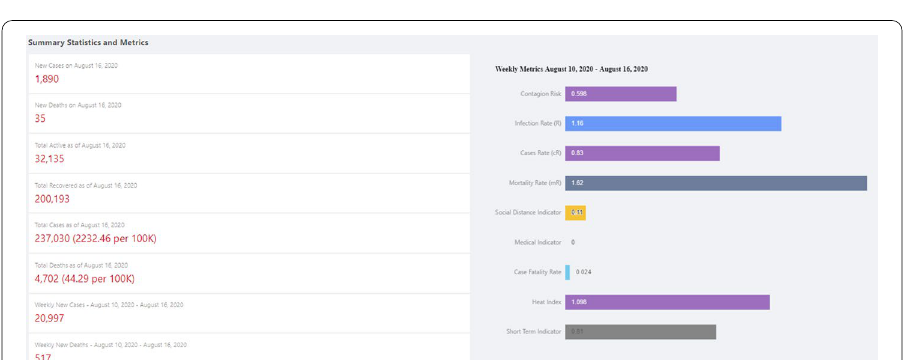
Fig. 11 Stats View: summary statistics and metrics at each